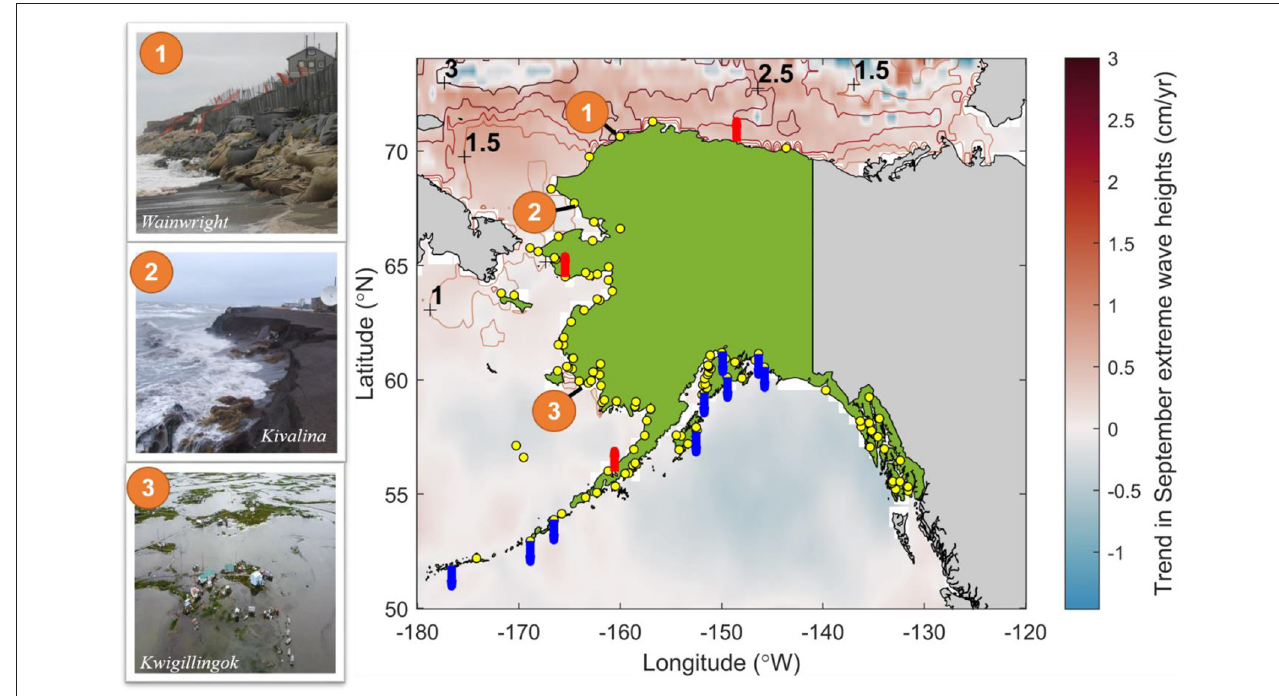
FIGURE 1 | Observed environmental changes affecting coastal flood hazards in Alaska. Sea level trends (red and blue colored arrows denoting rising and falling relative sea levels, respectively; National Oceanographic and Atmospheric Administration (NOAA), 2021), trend in annual duration of open water when the coast is exposed to storm surge and waves (contours, days/yr), and trend in 99th percentile wave heights (color scale) during the month of September (typically lowest annual sea ice extent). Wave height and open water duration trends were computed over the 35-year satellite era (1985–2019) with ERA5 reanalysis data ( Hersbach et al., 2018). Sea level trends are based on tide gauge records ranging from 28 to 68 years depending on the particular